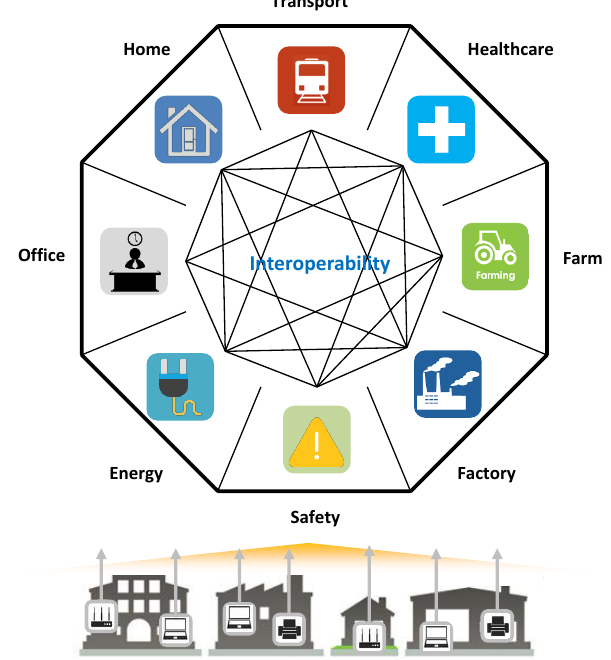
Figure 1. Interoperability between various service domains in a smart